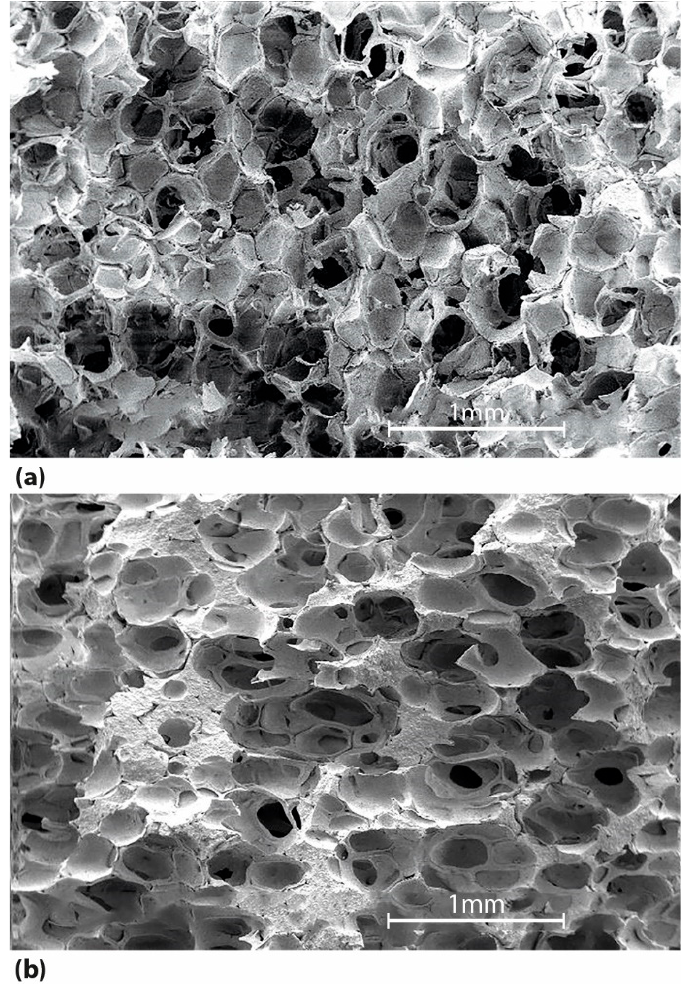
Figure 5. SEM micrographs of the fracture surface of the alumina foam manufactured using slurry 2A ( a ) and slurry 2B ( b ), respectively.